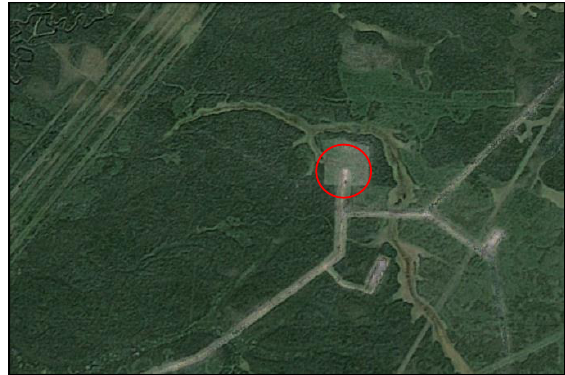
Figure 8. "Permanent Flares" object recognized as a gas flare in petroleum-producing enterprise. May 2014, West Siberia. © Google Planet Earth.